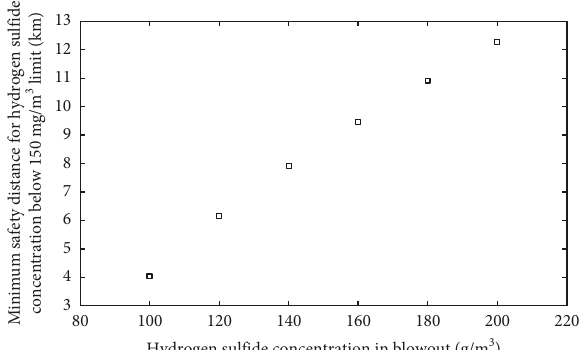
Figure 4: The relationship between the minimum safety distance and the concentration of H 2 S in